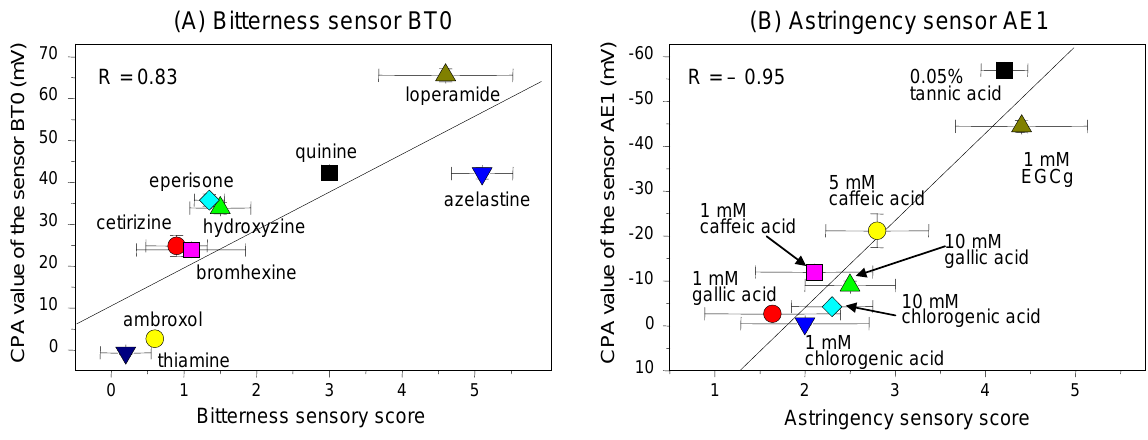
tastes. Tastes for Figs. 12A and 12B were scored by three and eight panelists, respectively. In Figure 12A, quinine hydrochloride concentrations of 0.01, 0.03, 0.1, 0.3, and 1.0 mM were used as standards and were assigned scores of 1, 2, 3, 4, and 5, respectively. In Figure 12B, tannic acid concentrations of 0.005%, 0.011%, 0.024%, and 0.05% were used as standards and were assigned scores of 1, 2, 3, 4, and 5, respectively. The standard deviations on the x- and y-axes are the difference between the panelists’ scores and measurement error (n = 4), respectively. All samples include 30 mM KCl and 0.3 mM tartaric acid as supporting electrolyte. EGCg: epigallocatechin